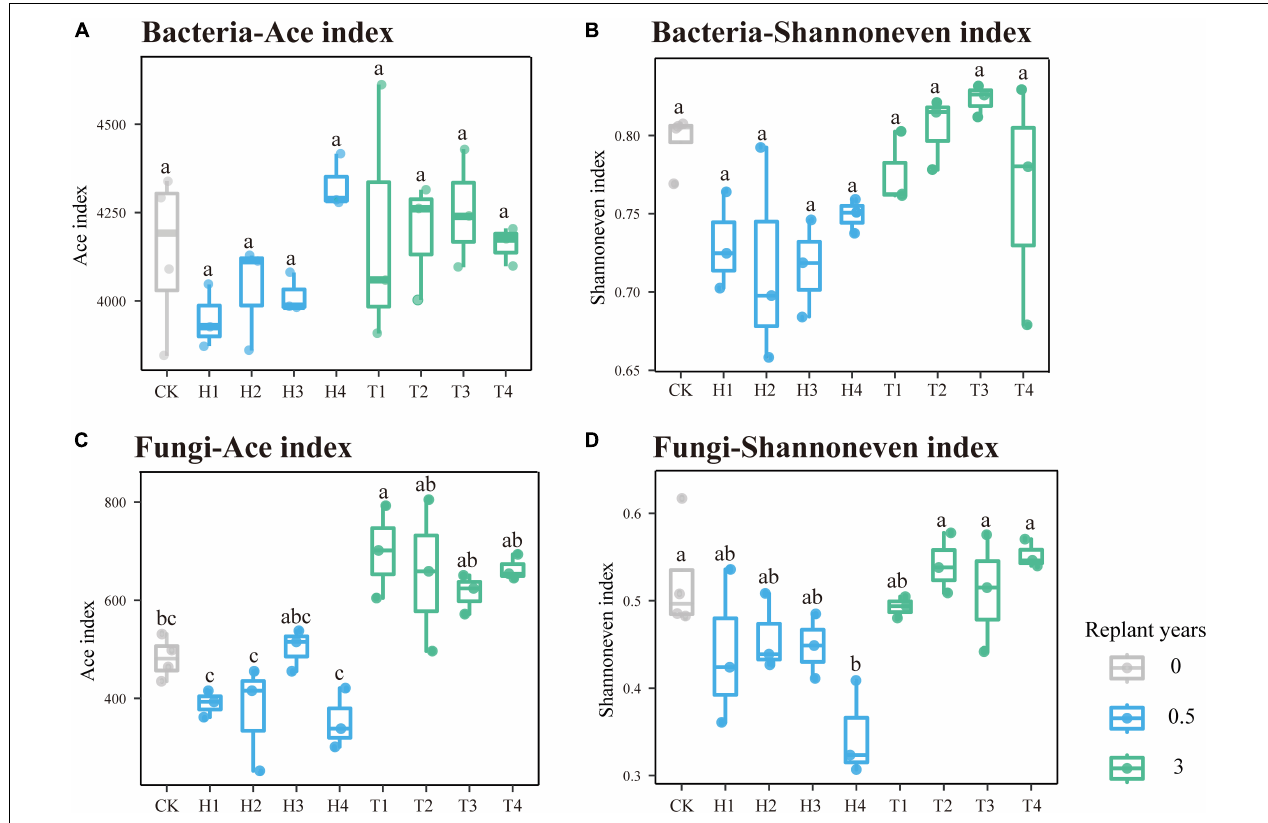
FIGURE 2 | Variations of the rhizosphere microbial community richness and evenness in different monoculture years. The ACE index indicates the richness of community, where the Shannon even index represents the evenness of the community. Box colors show the length of continuous monoculture time. (A,B) Prokaryotic community. (C,D) Fungal